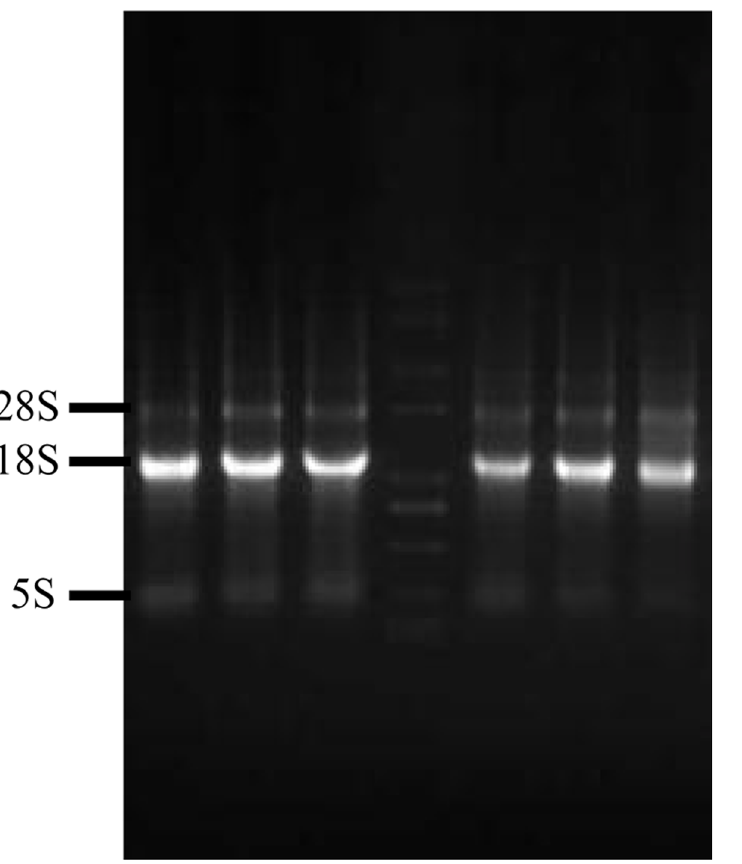
Fig 1. The electrophoresis results of total